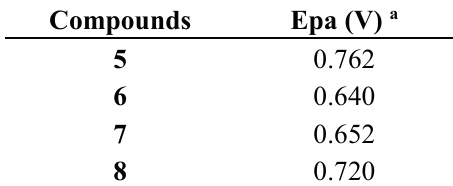
Table 1. Oxidant potentials recorded for the studied compounds.